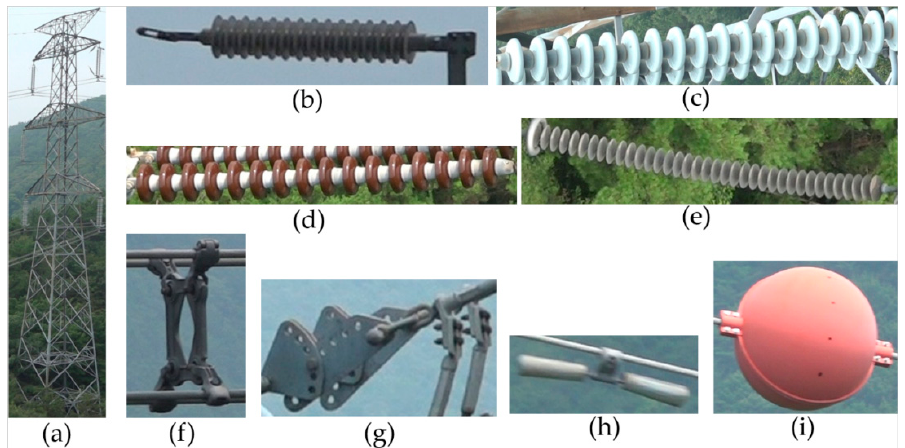
Figure 1. Example images of various types of transmission line components that can be detected by the proposed system. ( a ) Transmission tower; ( b ) Lightning-Arrester (LA); ( c ) suspension type white porcelain insulator; ( d ) suspension type red porcelain insulator; ( e ) polymer insulator; ( f ) spacer; ( g ) sag adjuster with bolted tension clamp; ( h ) vibration damper; ( i ) balisor.